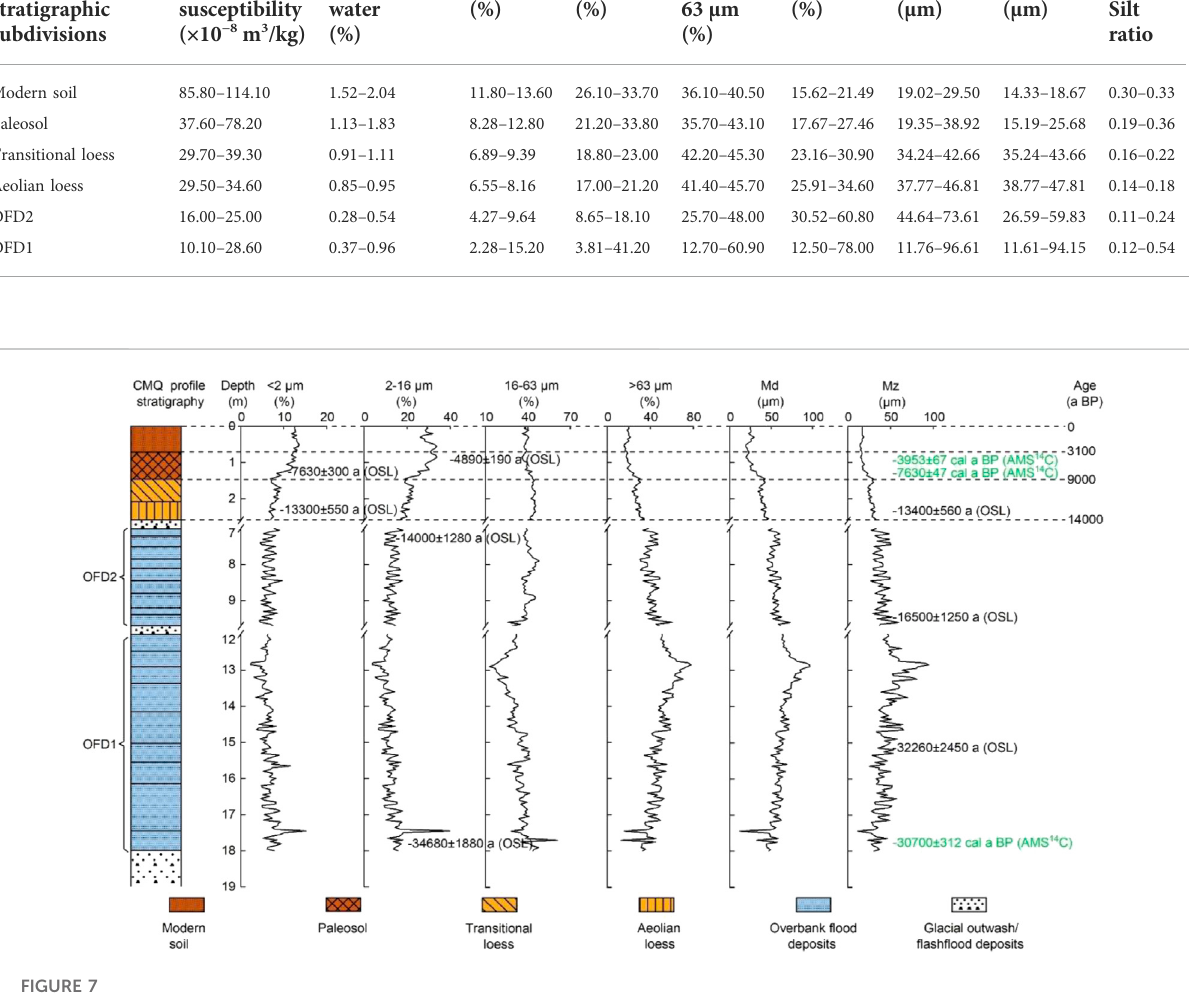
FIGURE 7 Pedo-stratigraphy and grain size distribution in the CMQ pro fi le in the Yellow River source area on the NE Tibetan